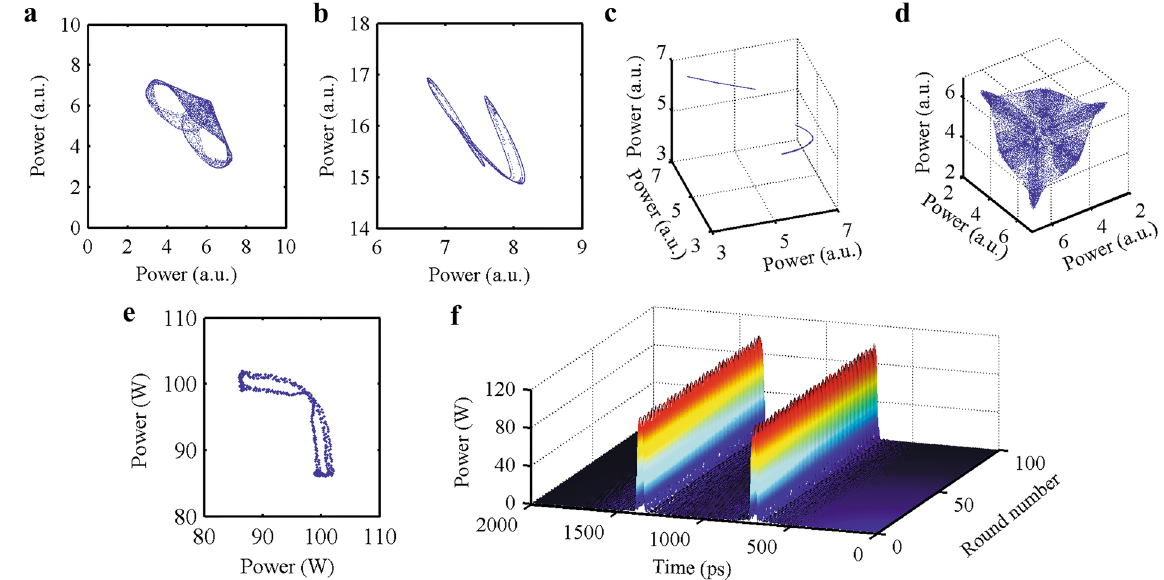
Figure 4. Chaos attractors in phase space. ( a , b ) shows the attractor for two pulses. ( c , d ) shows the attractor for three pulses. ( e , f ) shows the result derived by the full numerical